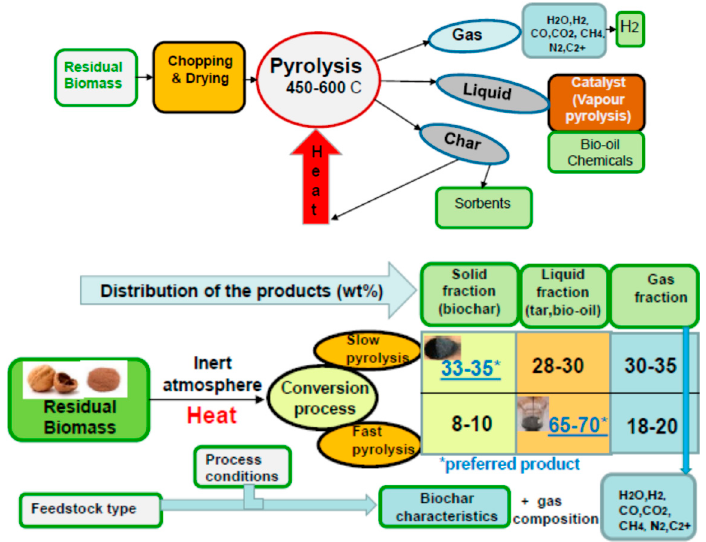
Figure 1. Possible products resulted from a pyrolysis process and the distribution of products.